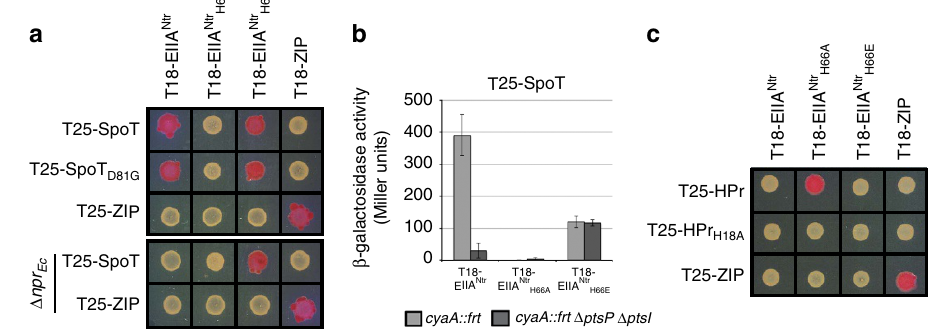
Figure 6 | The phosphorylated form of EIIA Ntr interacts with SpoT in BTH assays. ( a ) In contrast to EIIA Ntr H66A , EIIA Ntr B P and EIIA Ntr H66E directly interact with SpoT. MG1655 cyaA::frt (RH785) or MG1655 cyaA::frt D npr (RH2122) strains coexpressing T18- fused to ptsN , ptsN H66A , ptsN H66E or ZIP with T25- fused to spoT , spoT D81G or ZIP were spotted on MacConkey agar base plates supplemented with 1% maltose and 1mM IPTG. Plates were incubated for 3–4 days at 30 (cid:2) C. The red colour indicates positive interactions. ( b ) The absence of E. coli EI and EI Ntr proteins abolishes interaction between SpoT and EIIA Ntr but not with EIIA Ntr H66E . b -galactosidase assays were performed on strains coexpressing T25-SpoT and T18-EIIA Ntr , T18-EIIA Ntr H66A or T18- EIIA Ntr H66E , in the presence (MG1655 cyaA::frt (RH785)) or absence (MG1655 cyaA::frt D ptsP D ptsI (RH2124)) of EI and EI Ntr proteins. Error bars ¼ s.d.; n ¼ 3. ( c ) In contrast to HPr H18A , HPr B P directly interacts with EIIA Ntr H66A . MG1655 cyaA::frt (RH785) strain coexpressing T18- fused to ptsN , ptsN H66A , ptsN H66E or ZIP with T25- fused to hpr , hpr H18A or ZIP were spotted on MacConkey agar base plates supplemented with 1% maltose and 1mM IPTG. Plates were incubated for 3–4 days at 30 (cid:2) C. The red colour indicates positive interactions. EIIA Ntr H66E remained unchanged in this background (Fig. 6b). no more b -galactosidase activity was detected in a D ptsP D ptsI background (without E. coli EI proteins) expressing T25-SpoT Finally, the expression of Caulobacter ptsH (HPr) from the and T18-EIIA Ntr , while the interaction between SpoT and inducible pBAD promoter (pBAD33 -ptsH Cc ) in a D npr NATURE COMMUNICATIONS|7:11423|DOI: